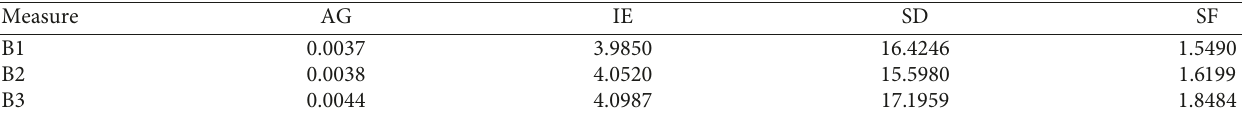
Table 5: The average